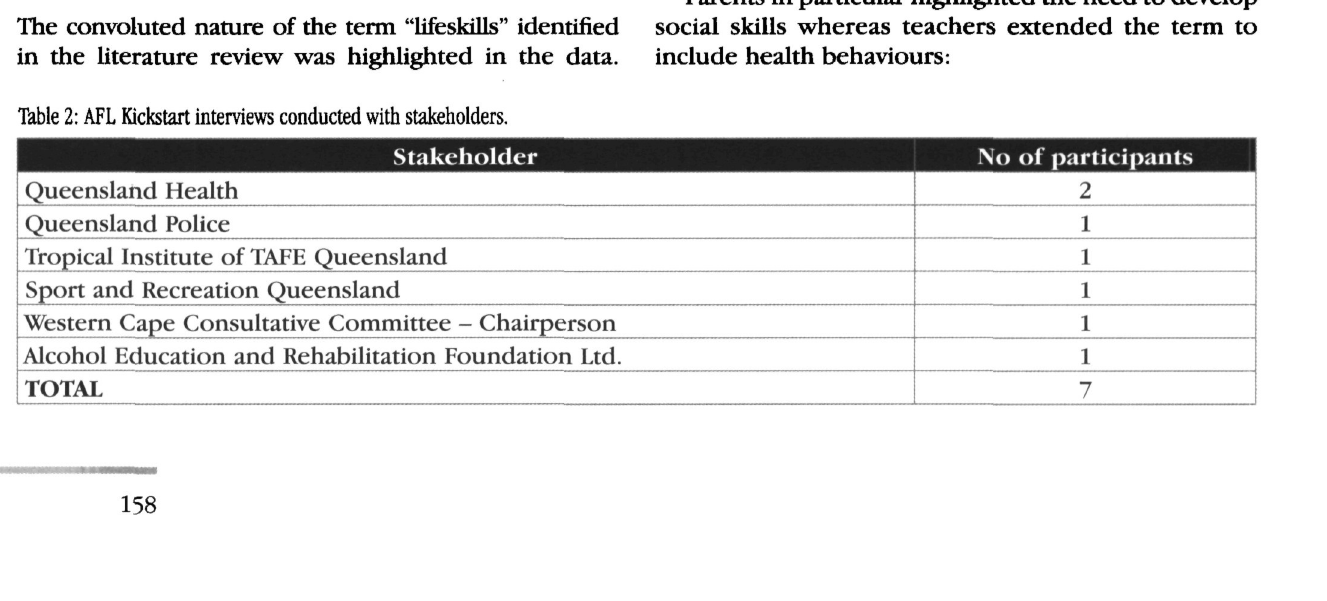
Table 2: AFL Kickstart interviews conducted with